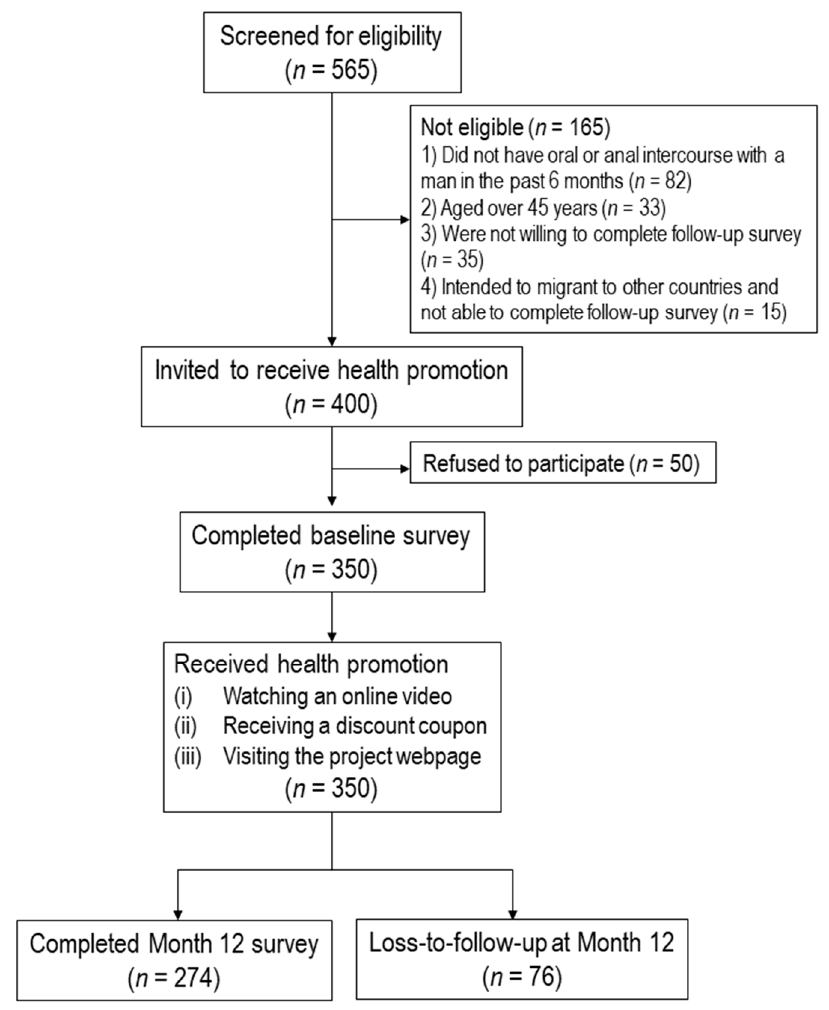
Figure 1. Flowchart diagram.